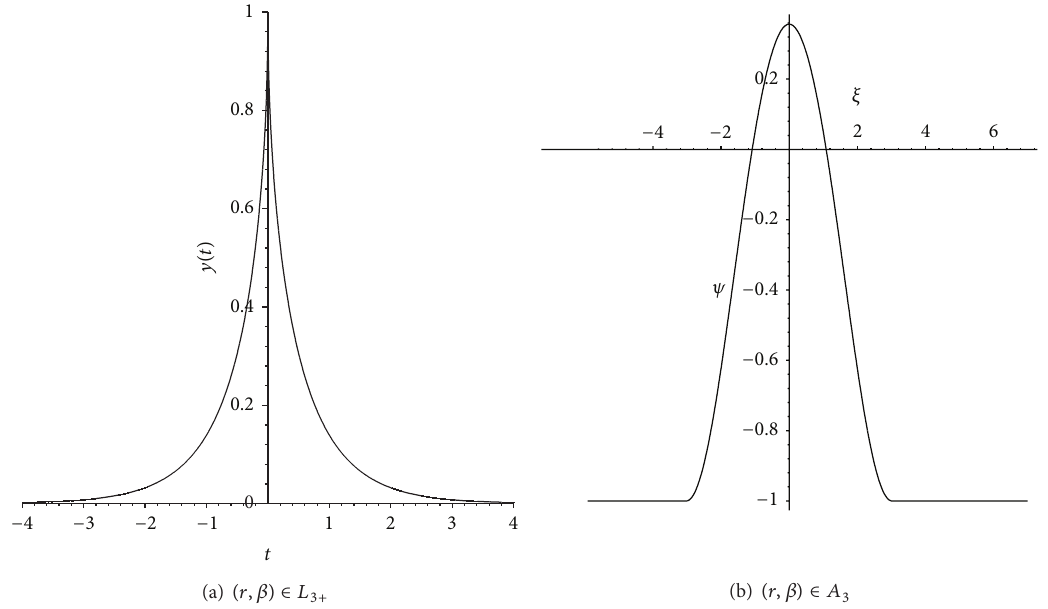
Figure 4: The cuspon and compacton solutions of (8) for 𝛼 < 0